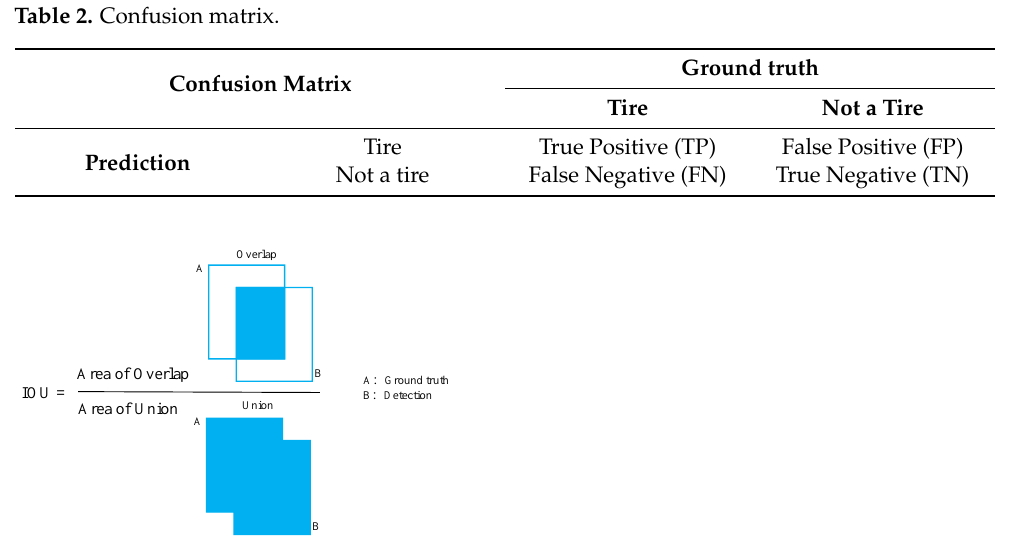
Figure 10. Intersection Over the Union.